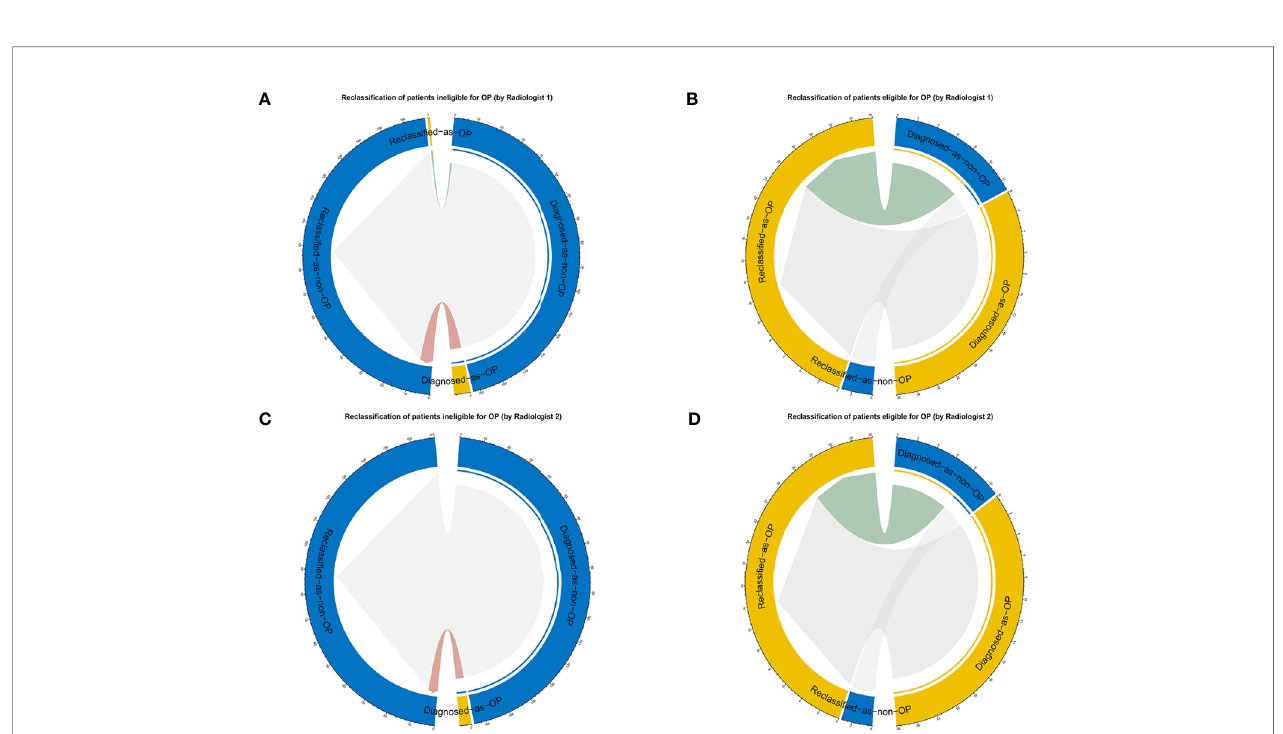
FIGURE 8 | The reclassi fi cation results are shown as circle plots. Reclassi fi cation of patients for different groups ( A, B for radiologist 1, and C, D for radiologist 2). Groups were illustrated according to the molder of the radiologists with the aid of a nomogram. OP, ovarian